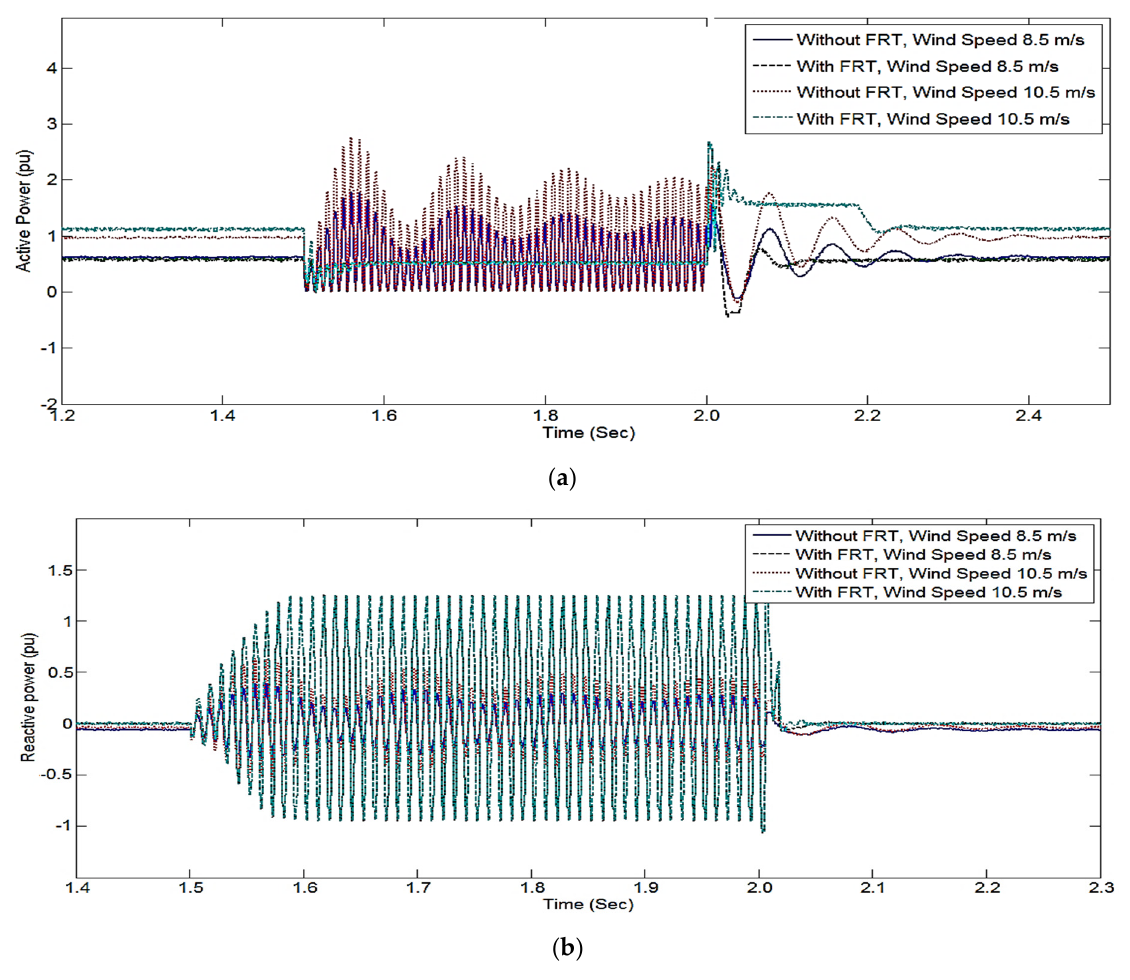
Figure 9. Behavior of WECS during unsymmetrical fault, with and without FRT control for 8.5 m/s and 10.5 m/s wind speed: ( a ) Active power supplied, ( b ) Reactive power supplied by the